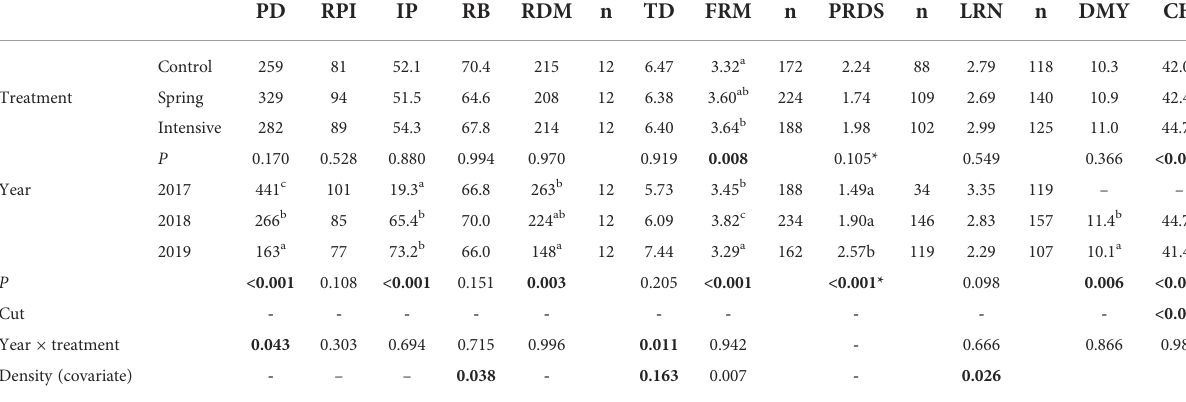
TABLE 4 Effect of treatment and year for Site 2 (Jev ı ́ c ̌ ko) on lucerne plant density (PD, plant m -2 ), root potential index (RPI), ratio of infected plants (IP, as %), ratio of branch-rooted plants (RB, as %), total root dry matter (RDM, g m -2 ), tap root diameter (TD, mm), fi ne root mass